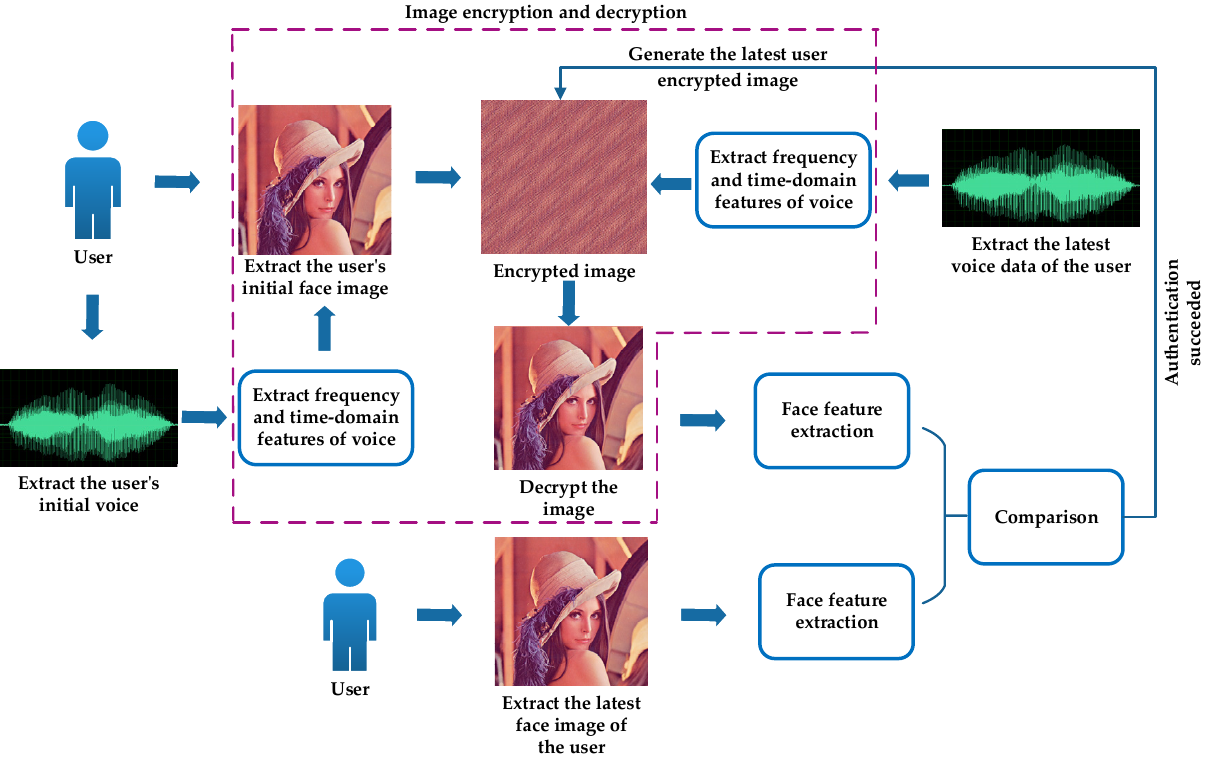
Figure 5. Authentication process of the identification method in this article.